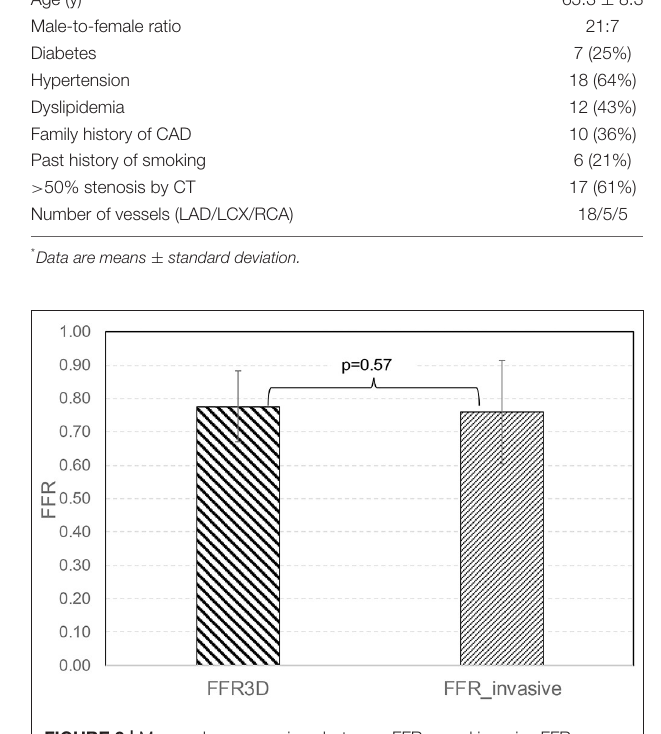
FIGURE 2 | Mean value comparison between FFR 3D and invasive